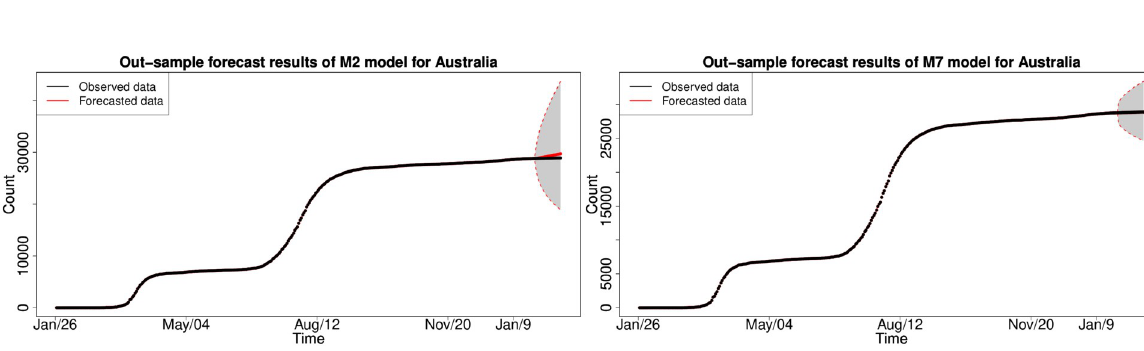
PLOS ONE | https://doi.org/10.1371/journal.pone.0253381 June 28,